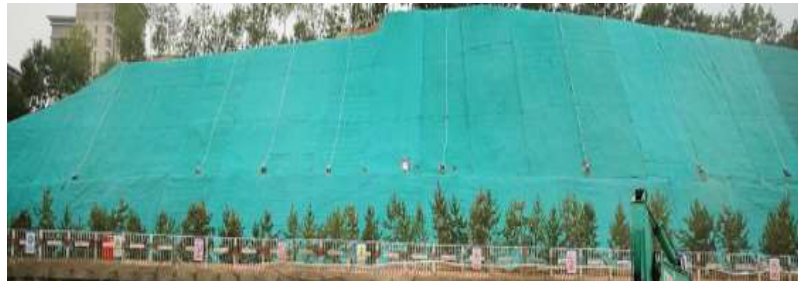
Figure 10. Layout of measuring points for slope horizontal displacement.